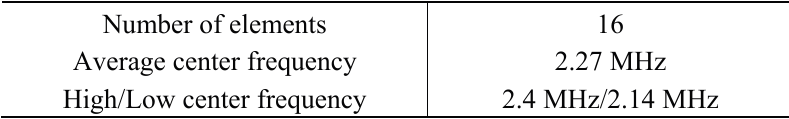
Table 4. Measured Properties of the 16-Elment Linear